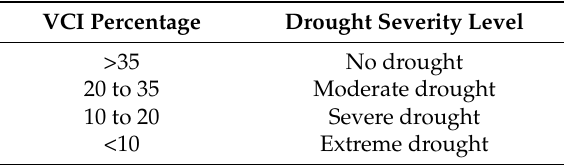
Table 1. Drought classification levels using Vegetation Condition Index (VCI) extracted from Moderate Resolution Imaging Spectro-radiometer Normalized Difference Vegetation Index